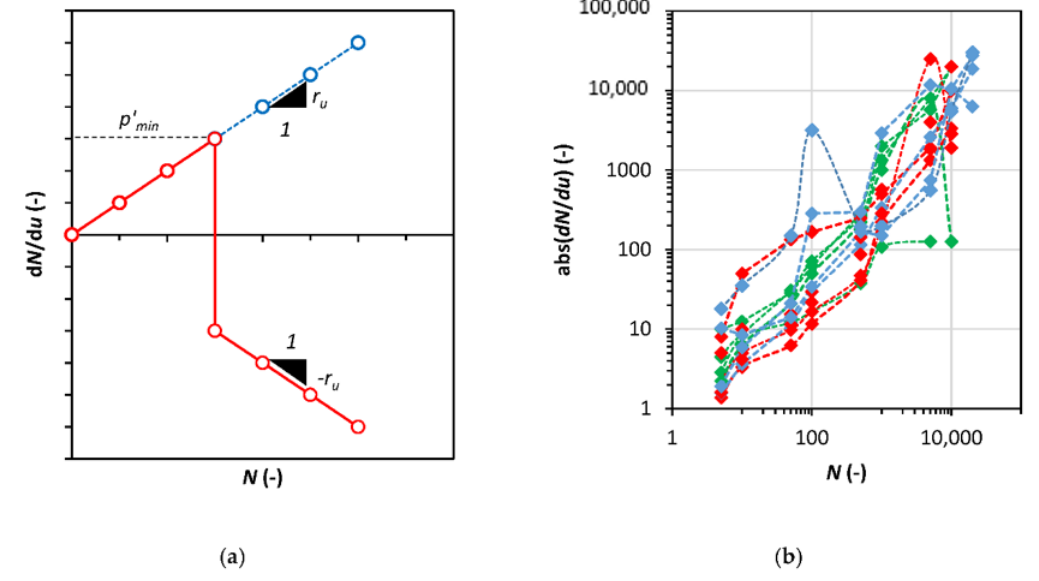
Figure 9. ( a ) Mechanism of pore pressure development during cyclic loading; ( b ) Test results for the dN/du characteristics from cyclic triaxial